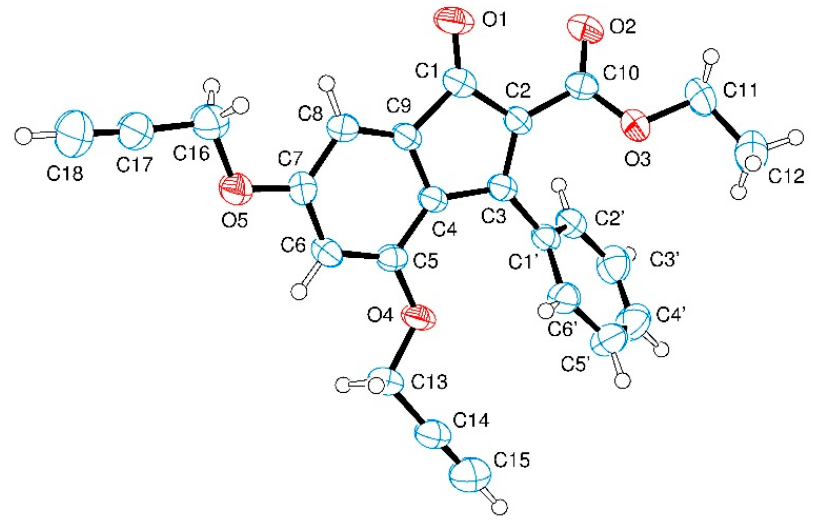
Figure 3. Structure of indenone derivative 5 found by crystallography. Ellipsoids enclose 50% probability.